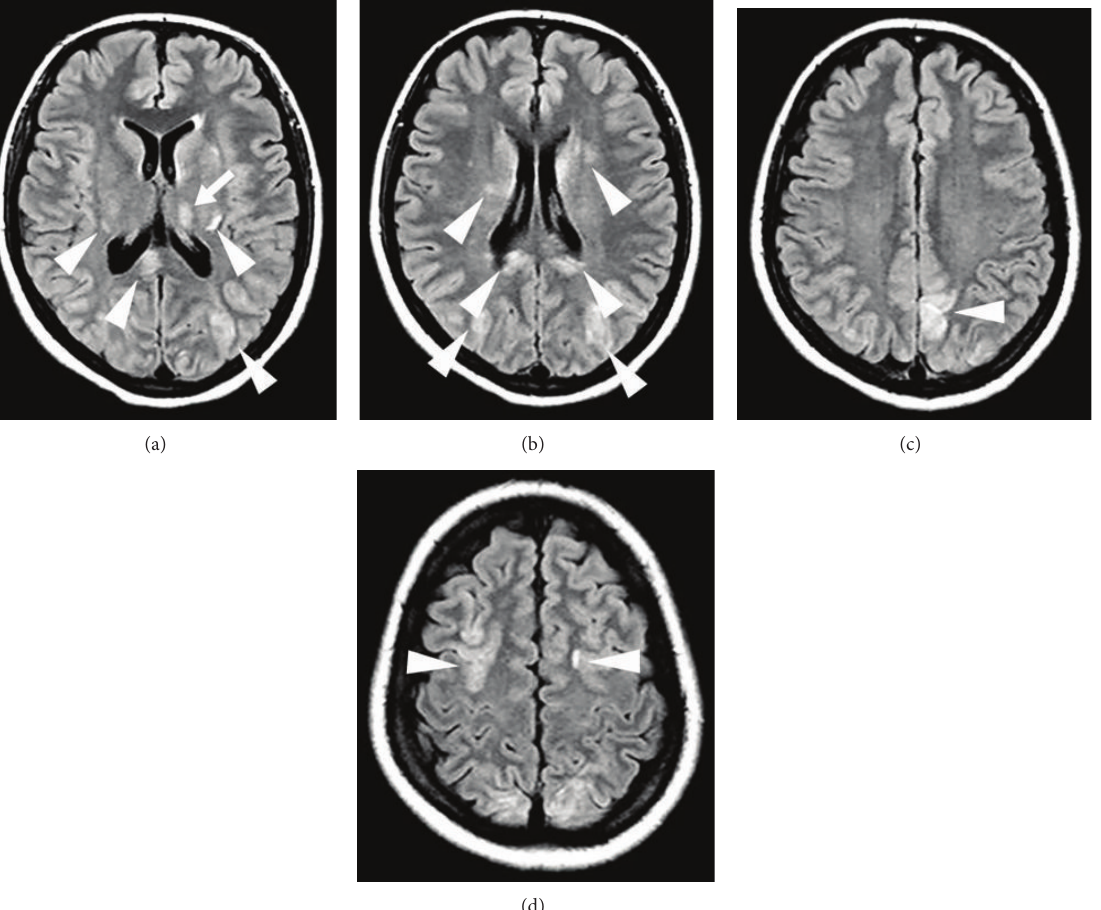
Figure 13: A patient with preeclampsia-related reversible posterior leukoencephalopathy syndrome with cortical and subcortical (arrowhead on a, b, c, and d) vasogenic edema seen as hyperintensity on FLAIR sequences also present in the left thalamus (arrow,